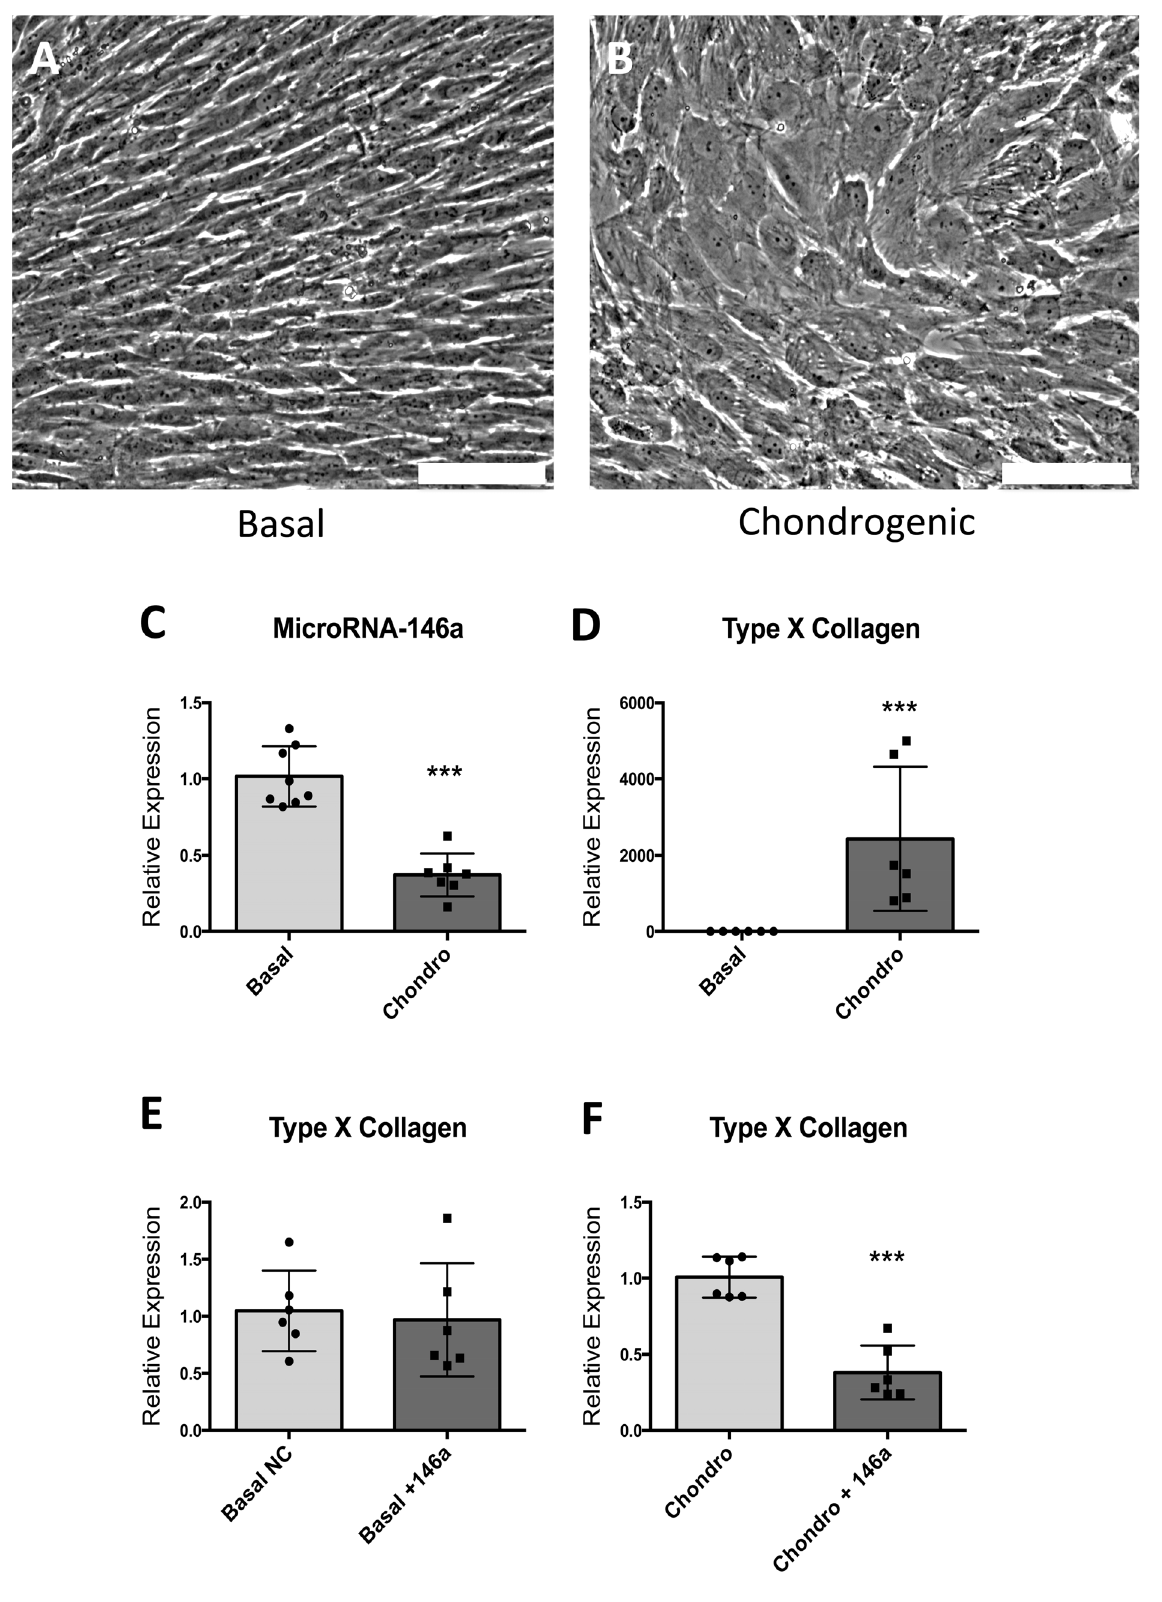
Figure 8. The effect of chondrogenic media containing 4 ng/ml of TGF- b 3 on morphology of cells in monolayer culture and the expression of miR-146a and Type X Collagen mRNA. TGF- b 3 addition (chondrogenic media) culminated in cells with a distinct hypertrophic phenotype (A–B). Expression of miR-146a was reduced following culture under chondrogenic conditions (C) and a significant up-regulation of Type X collagen was observed (D). Under basal condition, miR-146a expression did not affect the expression of Type X Collagen (E). Under chondrogenic